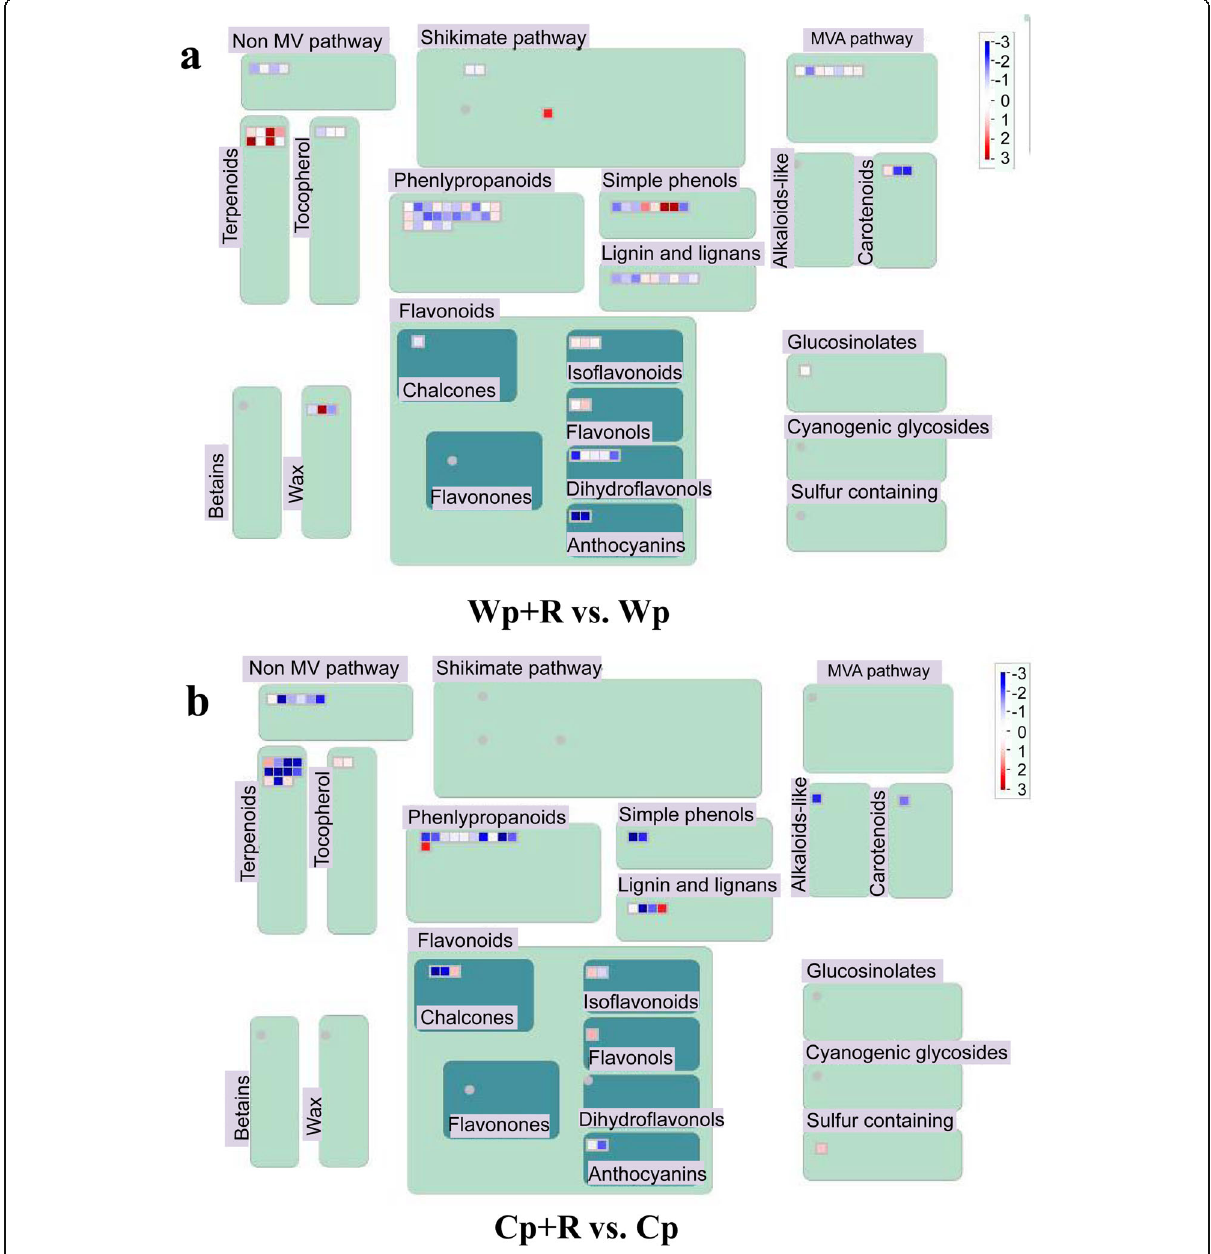
Fig. 7 Analysis of secondary metabolic pathway of Rhizoglomus intraradices -inoculated plants to infection by Magnaporthe oryzae using MapMan 3.6.0. ‘ Wp+R vs. Wp ’ ( a ) and the ‘ Cp+R vs. Cp ’ ( b ) comparisons. Cp + R, R. intraradices -inoculated cultivated rice infected with M. oryzae ; Cp, R. intraradices -uninoculated cultivated rice infected with M. oryzae ; Wp + R, R. intraradices -inoculated wild rice infected with M. oryzae ; Wp, R. intraradices -uninoculated wild rice infected with M. oryzae . Red color intensity indicates the DEGs with log 2 (fold-change) > 0 and P value < 0.05, and blue color intensity indicates the DEGs with log 2 (fold-change) < 0 and P value < 0.05 according to the scale